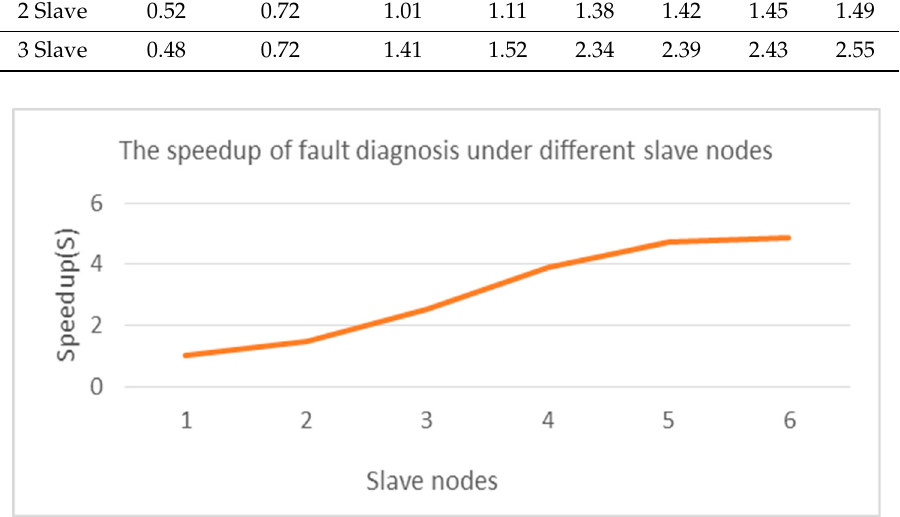
Figure 14. The speedup of fault diagnosis under different slave nodes.